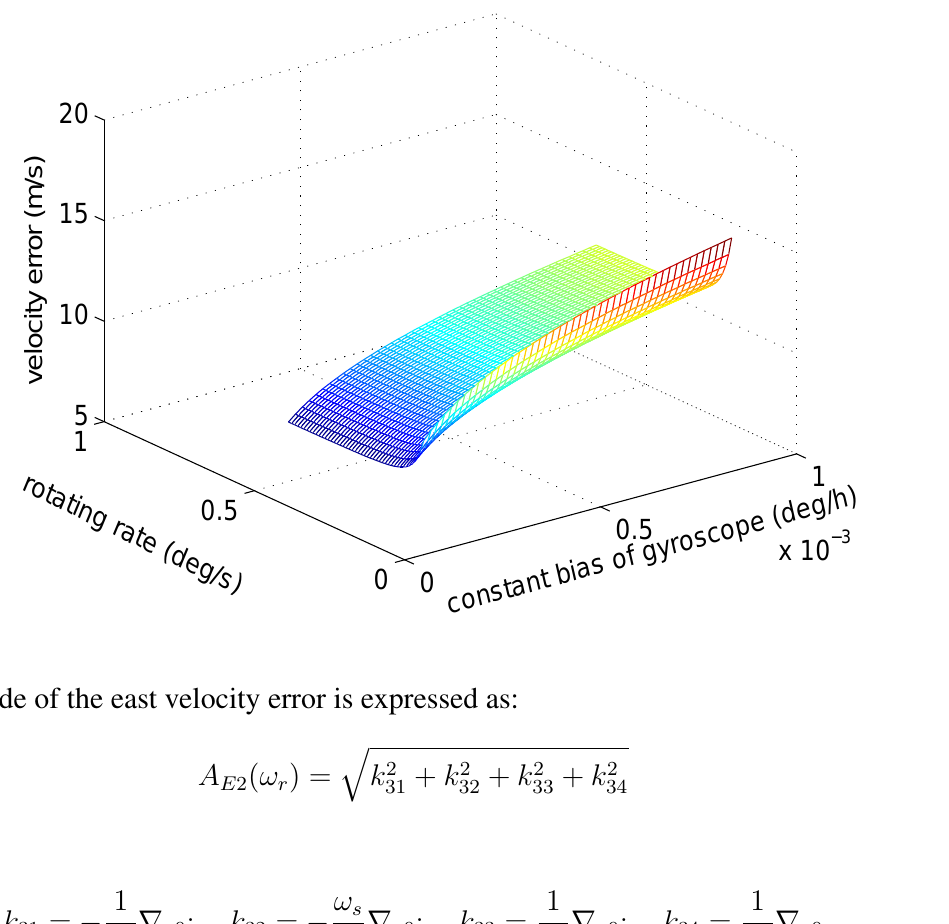
Figure 3. The relationship curve of the amplitude of the velocity error, the constant bias of the gyroscope and the rotating angular